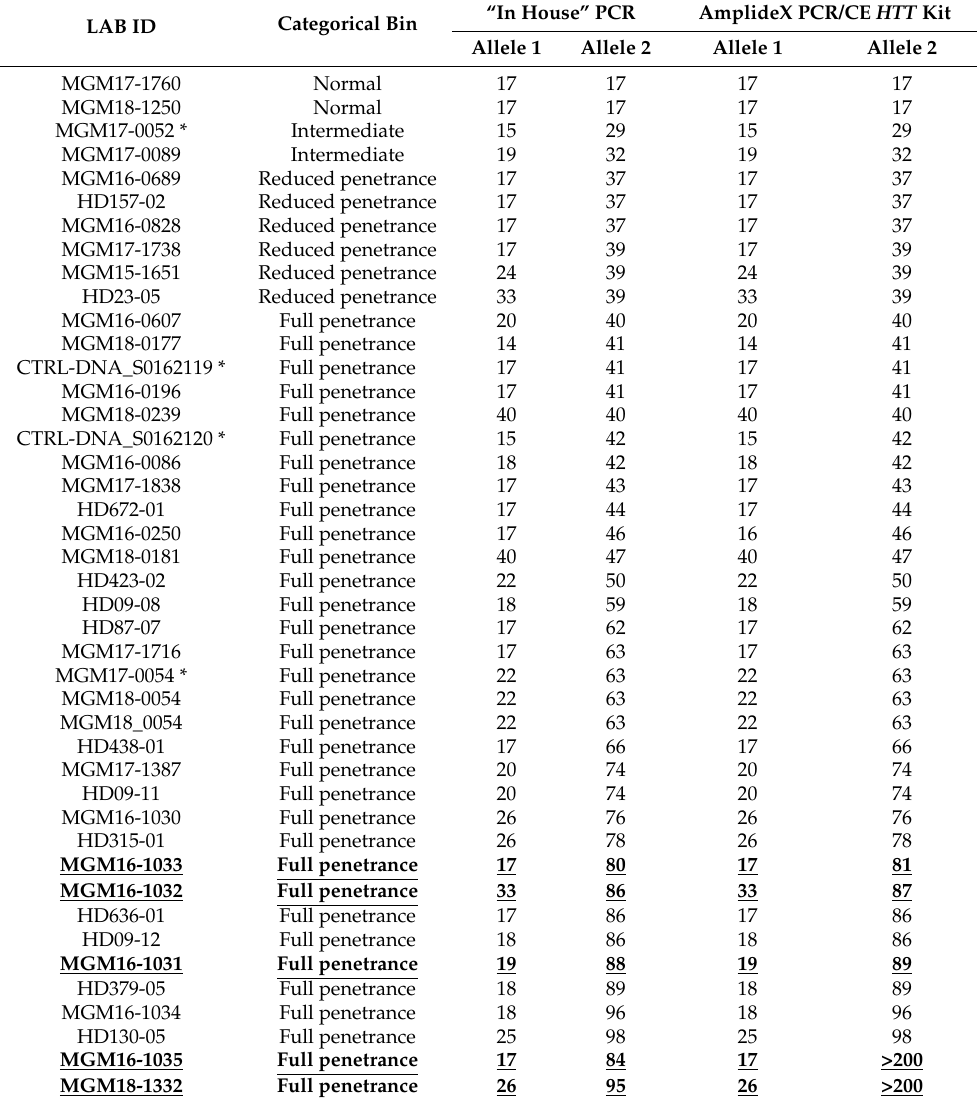
Table 2. HD samples used for this validation and corresponding genotypes obtained using fluorescent repeat-flanking